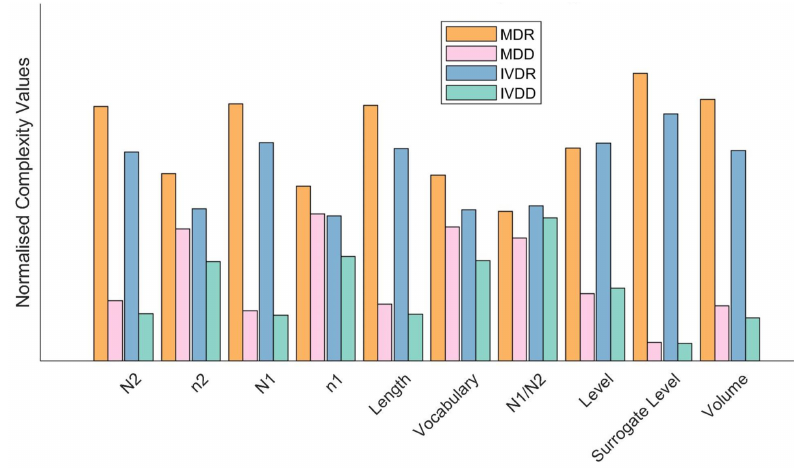
Figure 3. Halstead-based metric scores for the MDR, MDD, IVDR and IVDD. The following metrics are used: Total operators ( N 1 ), unique operators count ( n 1 ), total operands ( N 2 ) and unique operands count ( n 2 ). Other metrics consist of the length, vocabulary size, classification ratio ( N 1 / N 2 ), level, surrogate level and volume of the “programme”.